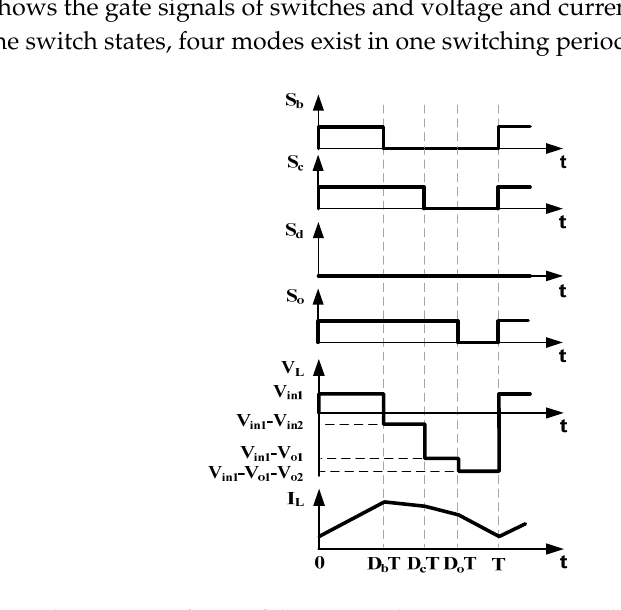
Figure 4. Steady ‐ state waveforms of the proposed power converter in the battery charging mode. Figure 4. Steady-state waveforms of the proposed power converter in the battery charging mode.